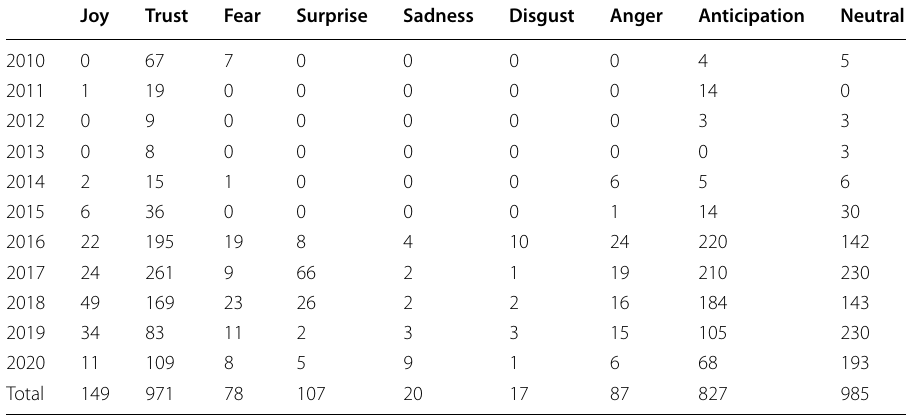
Table 13 Emotion frequency based on the most intense emotion of each tweet for each year over the years